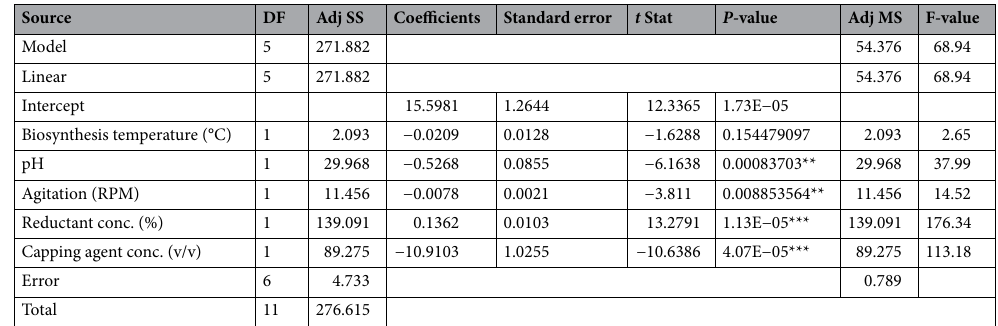
Table 4. Analysis of variance of Plackett–Burman design for biosynthesis reaction for ZnO NPs using cell-free extract of strain E56. *Significant